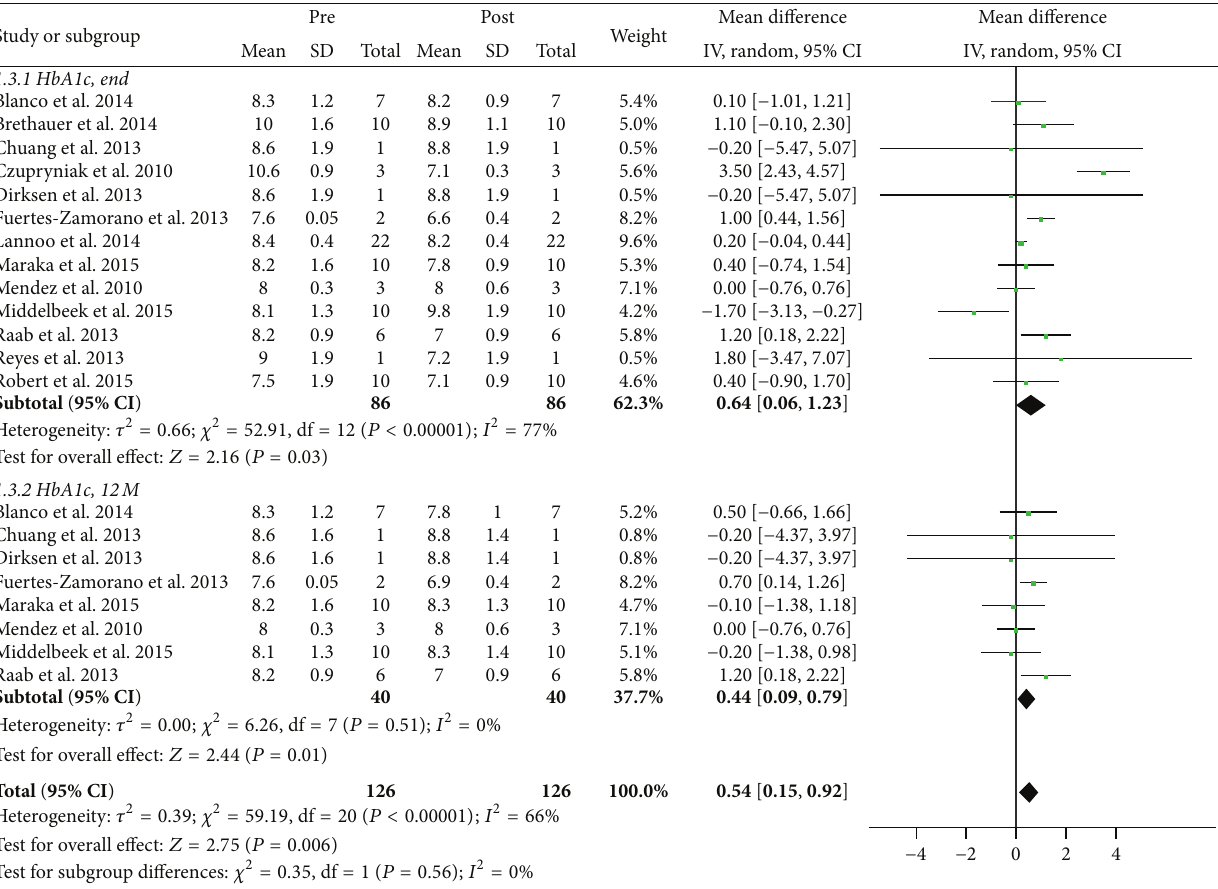
Figure 4: Meta-analysis of changes to HbA1c postoperatively at 12 months and at study endpoint. End indicates study endpoint; 12 M, at 12 months; pre, preoperative; post, postoperative; CI, confidence